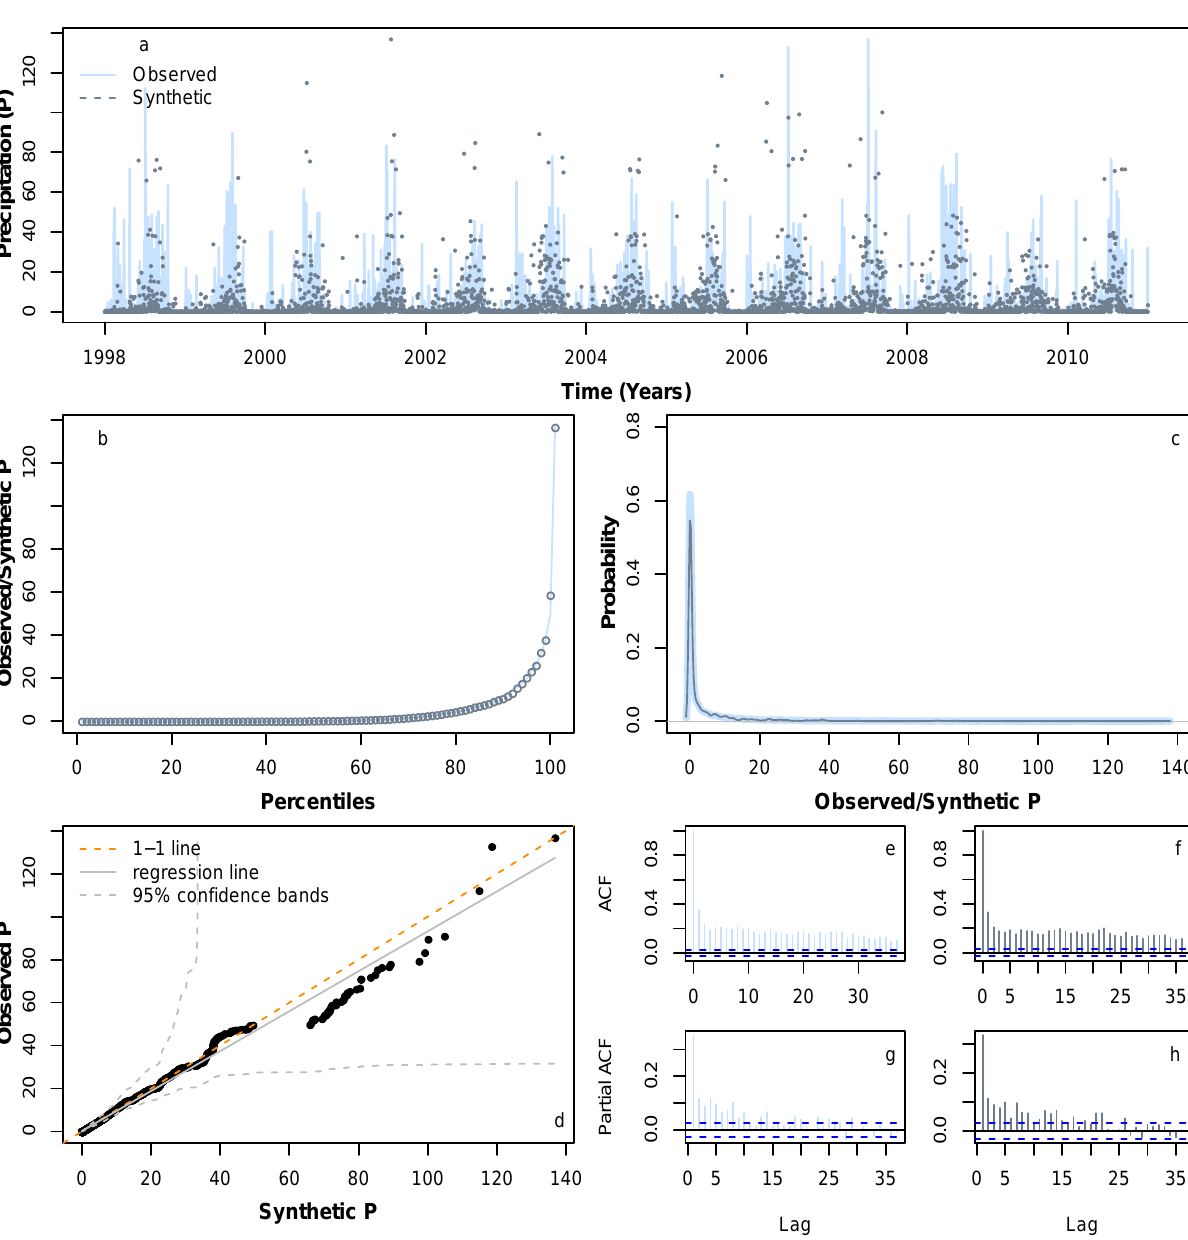
Figure 7. Comparison of various statistical characteristics of a sample synthetic P time series during the period 1998–2010 (dotted lines in slate grey), based on a learning P pattern from 1998 to 2010, with observed P 1998–2010 time series (solid lines in light slate grey). Comparing ( a ) realisation; ( b ) percentiles; ( c ) probability density distribution; ( d ) QQ-plot; ( e ) ACF for observed; ( f ) ACF for a sample synthetic series; ( g ) PACF for observed; and ( h ) PACF for a sample synthetic